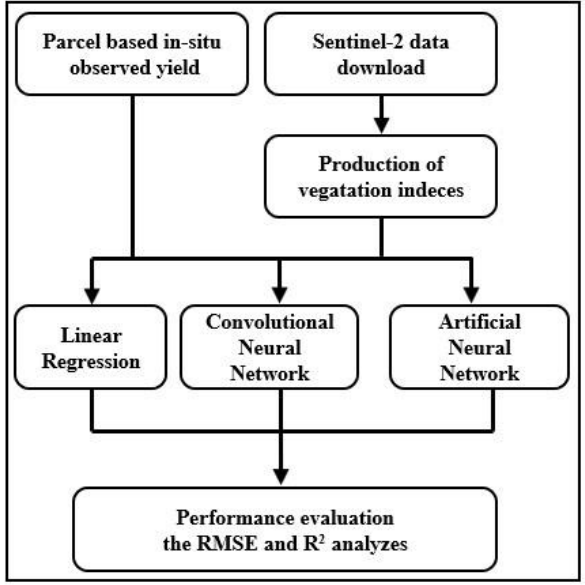
Figure 1. The workflow of the methodology.